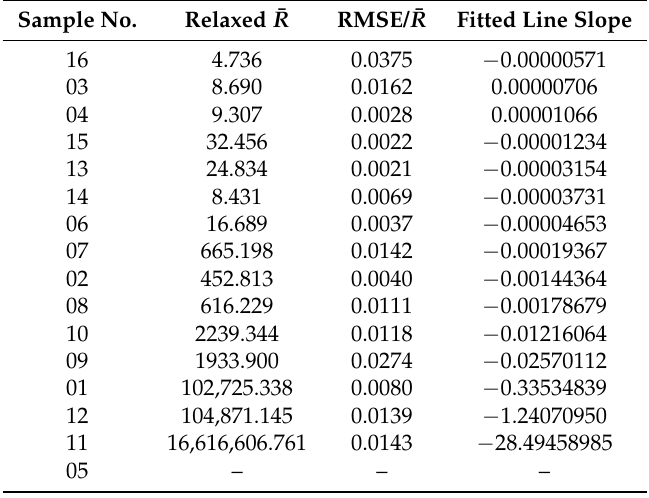
Figure 13. The fitting of Sample 1 while the sensor is at 70% strain. The EeonTex is a representational average result of all the samples. Table 9. Results of sensors held at a constant strain of 10% (ranked by slope). Sample